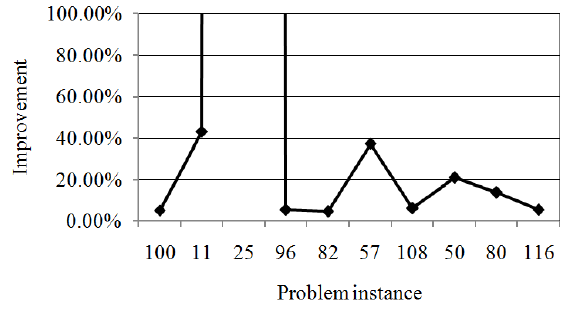
Fig. 3. Improvement of ACO GO over ACO GO